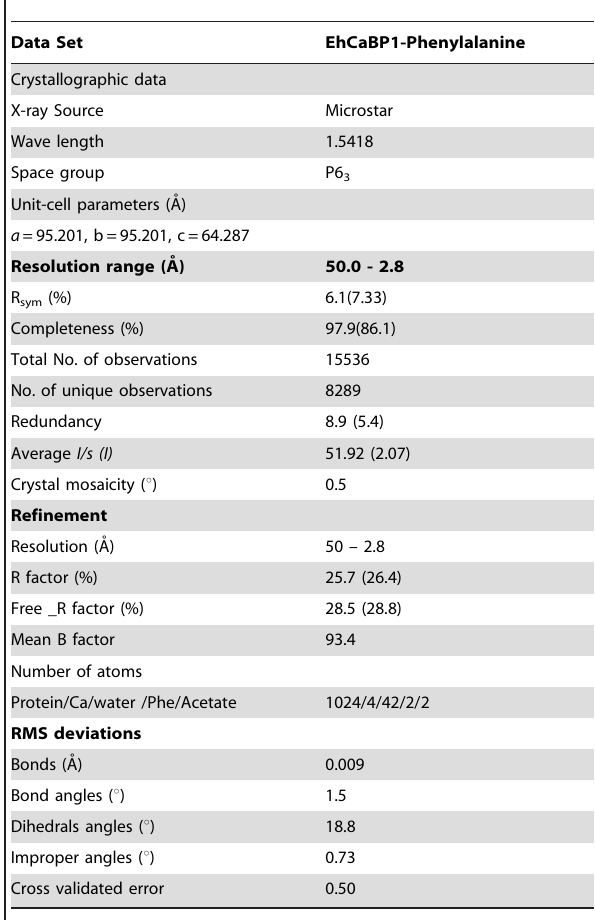
Table 1. Data-collection and refinement